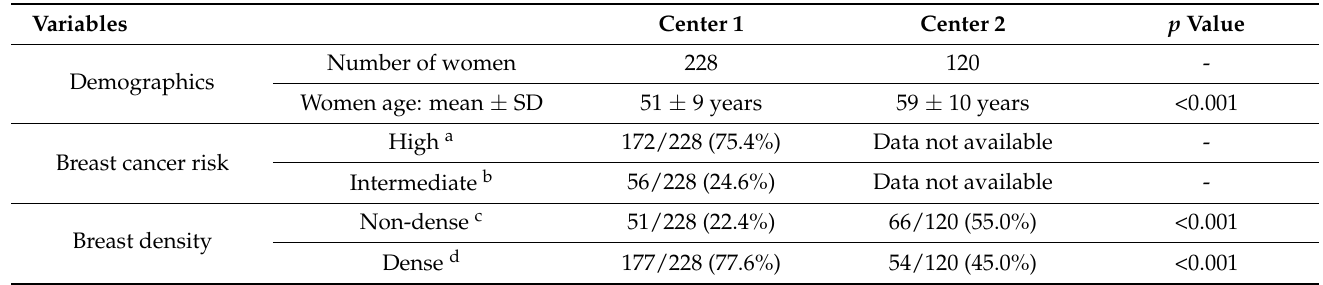
Table 1. Characteristics of the study population, obtained by pooling data from two prospective studies using CEM for different screening applications.